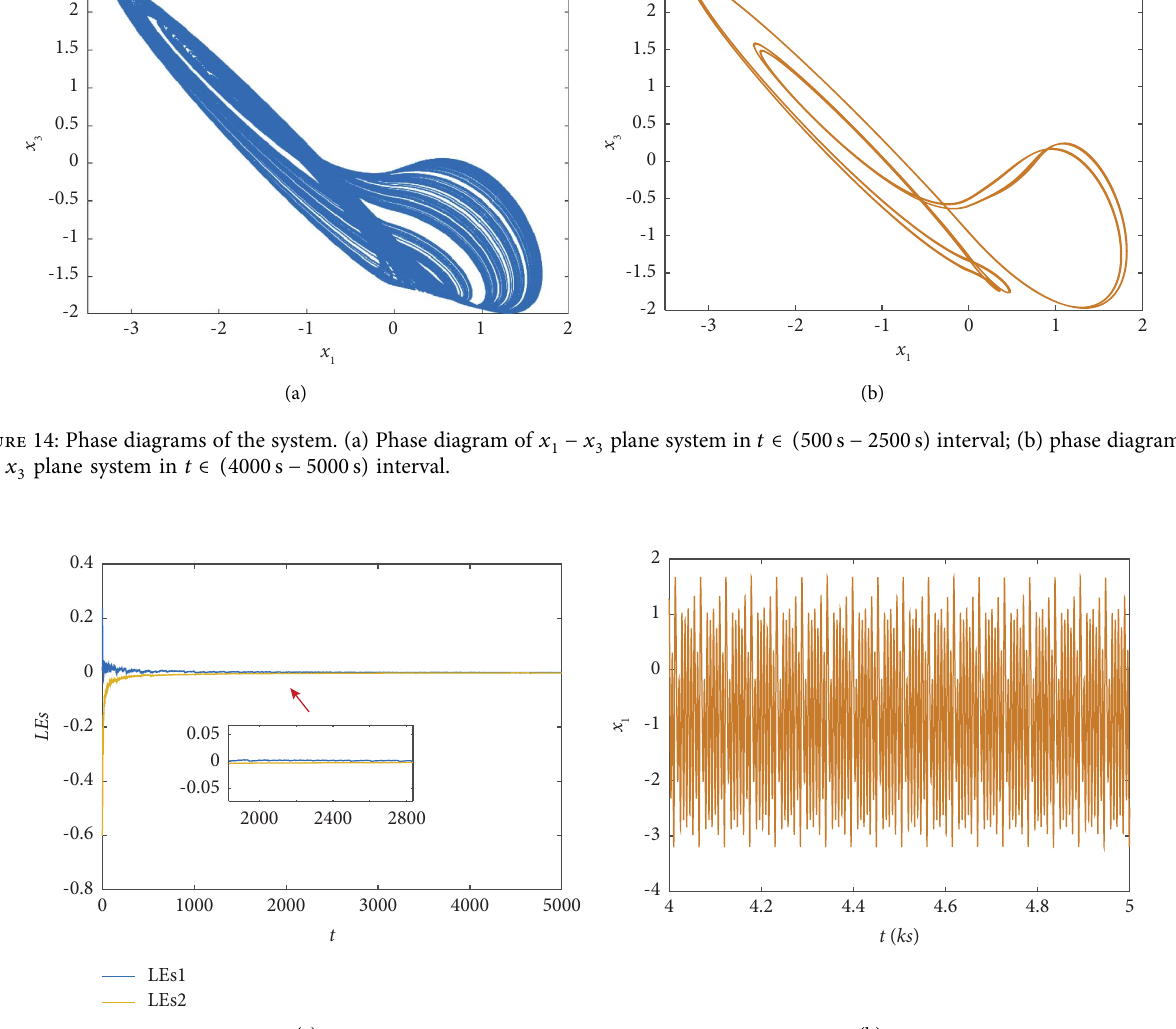
in interval t ∈ ( 4000s , 5000s ) 1